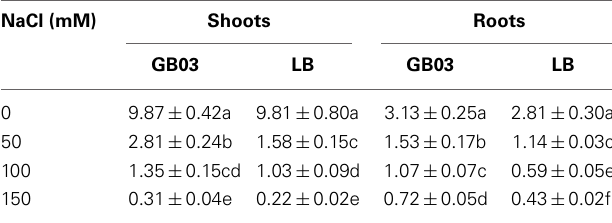
Table 1 | Effects of GB03 bacterization on K + /Na + ratio in shoot and root of white clover under various concentrations of